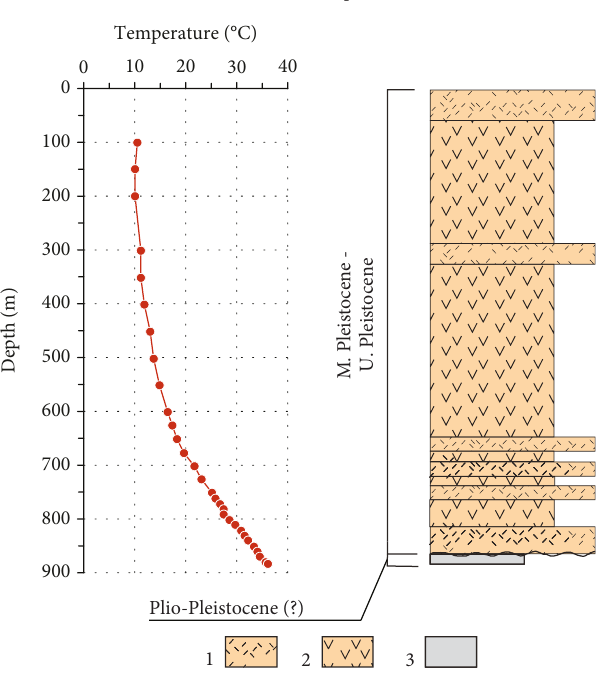
Figure 2: Temperature pro fi le and stratigraphy of the Gallo well (85-1) [7]. Key to the legend: (1) lava fl ow (VC), (2) tu ff (VC), and (3) sandstones